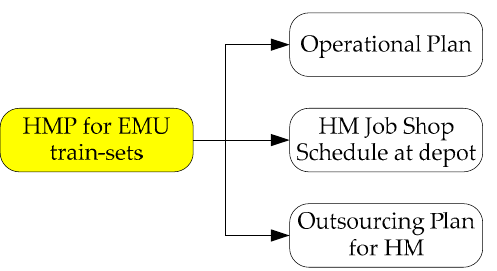
Figure 1. The high-level maintenance plan (HMP) process at China Railway Corporation (CR). EMU: electric multiple unit; HM: high-level maintenance.